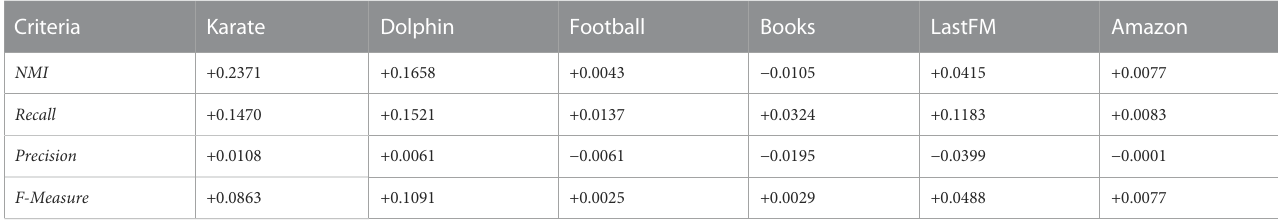
TABLE 6 The difference between LCDPC1 and LCDPC2